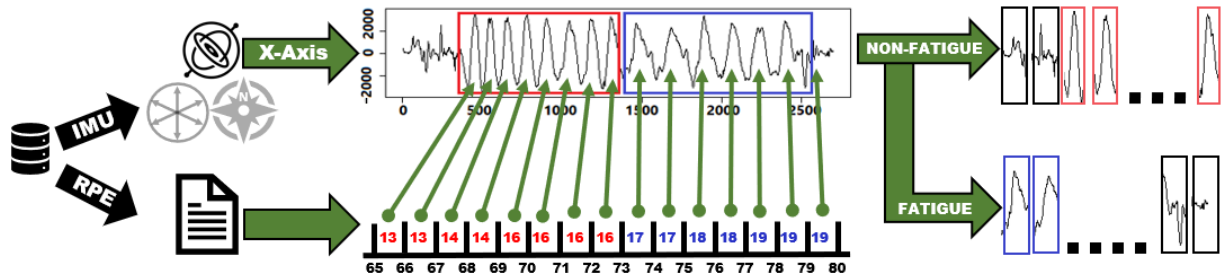
Figure 4. An example of extracting and labeling repetitions of the fifth set from the gyroscope’s